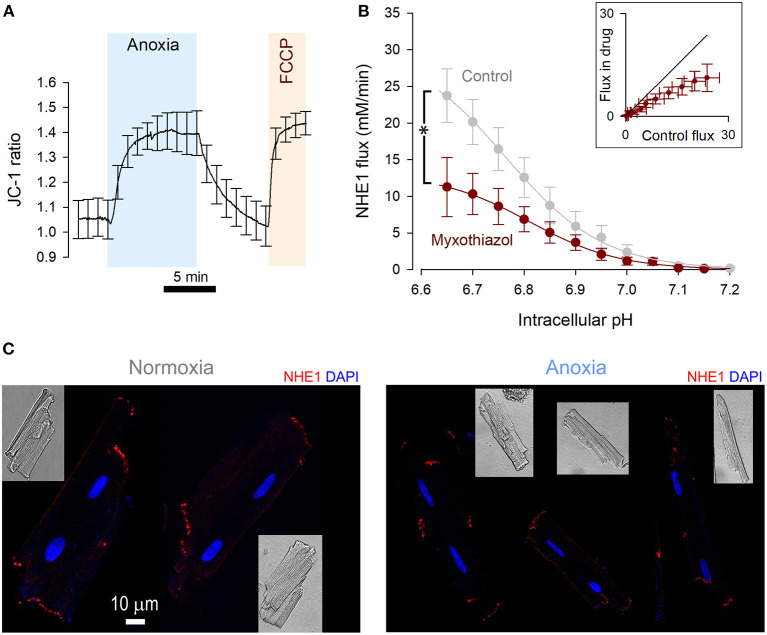
NHE1 activity is reduced by metabolic inhibition. (A) JC-1 fluorescence ratio measured in rat ventricular myocytes (n = 12 cells from 4 rats), showing mitochondrial depolarization in response to anoxic conditions. The response was comparable to the effect of FCCP (5 μM), indicating a complete depolarization by anoxia. (B) NHE1-generated flux measured in ventricular myocytes in the presence myxothiazol (1 μM, n = 7 cells from 3 rats), compared to controls. Two-way ANOVA: significant effect of drug (P < 0.0001); of pHi (P < 0.0001); and interaction (P = 0.0461). Inset plots flux in the presence and absence of inhibitor for matching pHi. (C) Immunofluorescence of rat ventricular myocytes for NHE1 under control conditions and after treatment with anoxic conditions for 15 min. NHE1 distribution appears unaltered. Scale bar applies to both images.